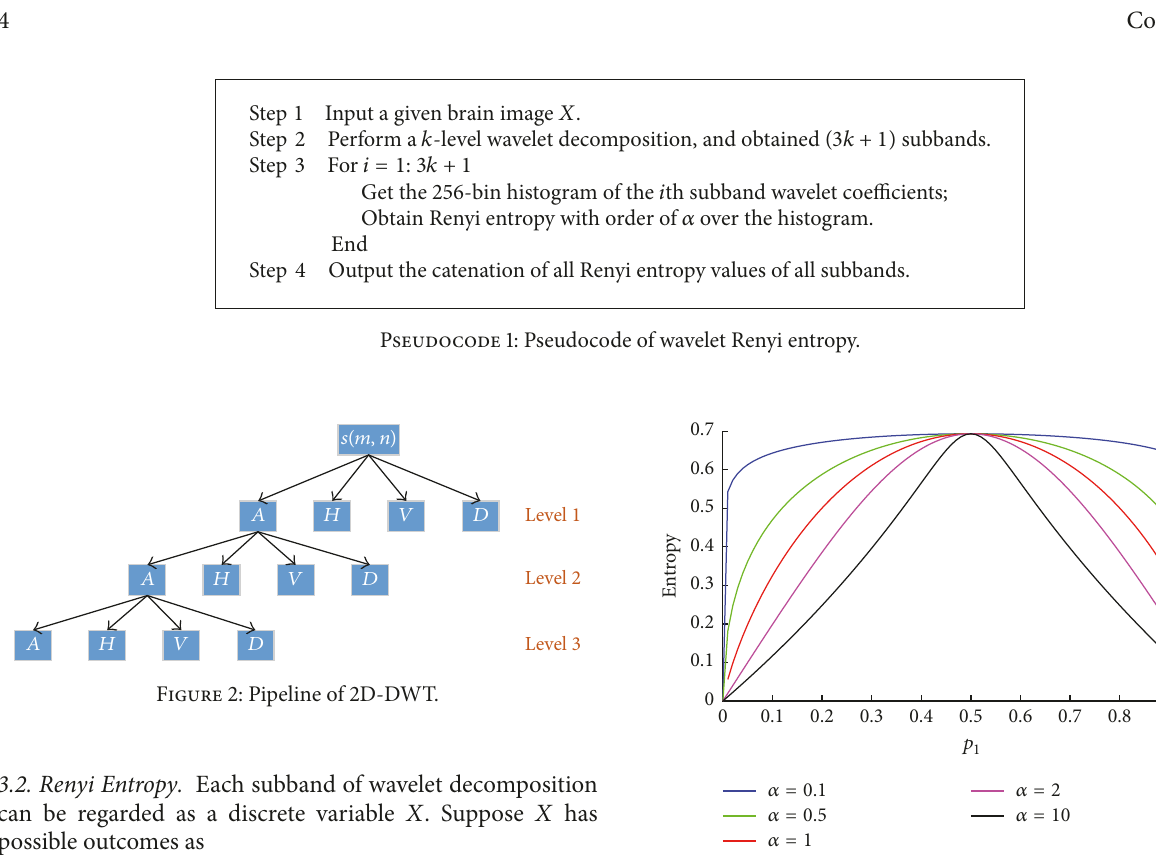
Figure 3: Renyi entropy with different 𝛼 -values for a binary random